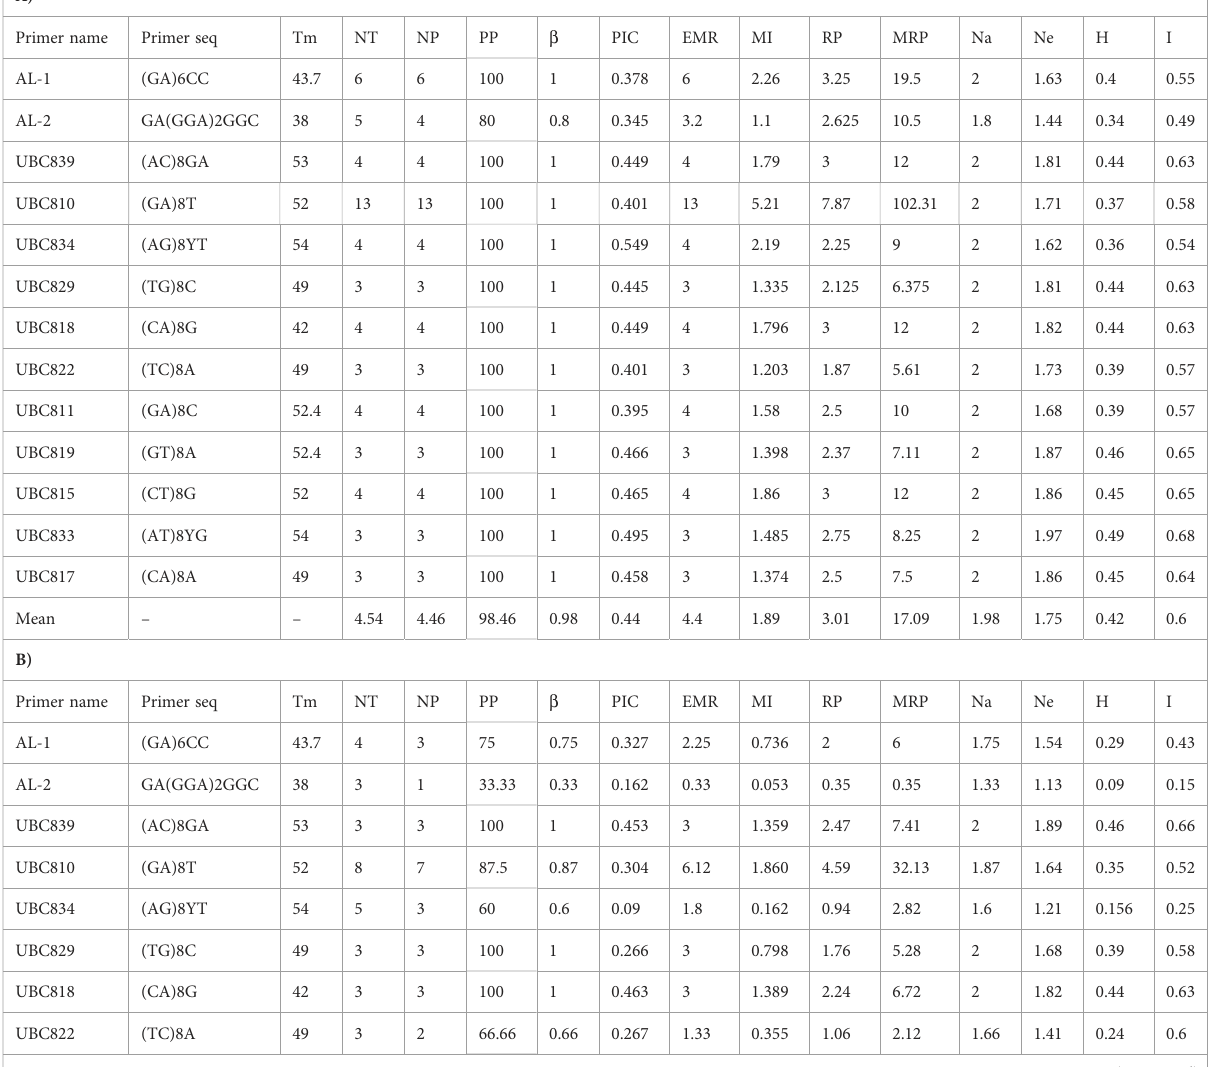
TABLE 2 Data of ISSR primers of 13 primers in A. retro fl exus (A) and C. album (B)